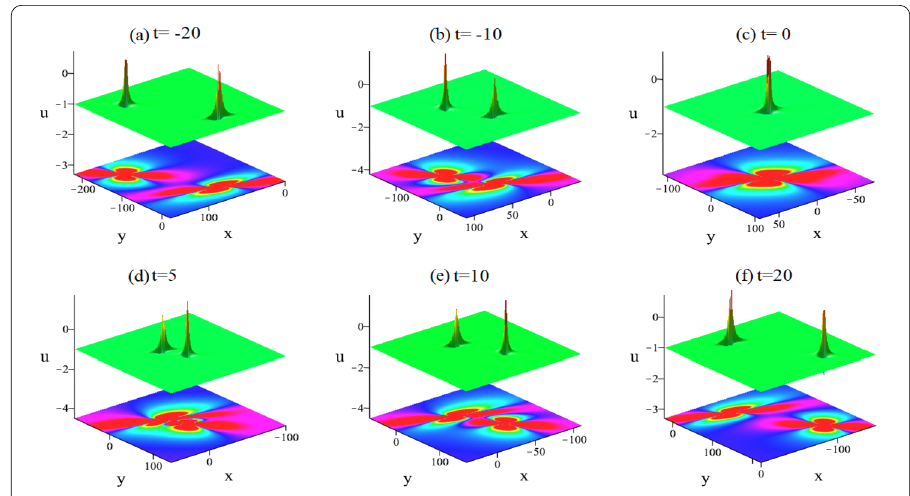
Figure 2 Surface (top) and density (bottom) plots of the interaction between two lumps with parameters in Eq. (13) at different time